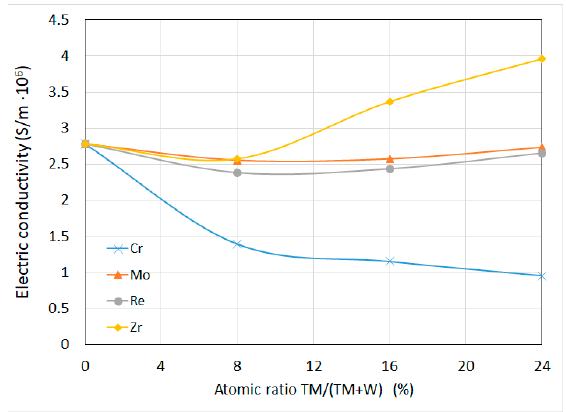
Table 3. Electrical conductivity of TM (TM = W, Cr, Mo, Re, Zr) diborides and tungsten carbide.